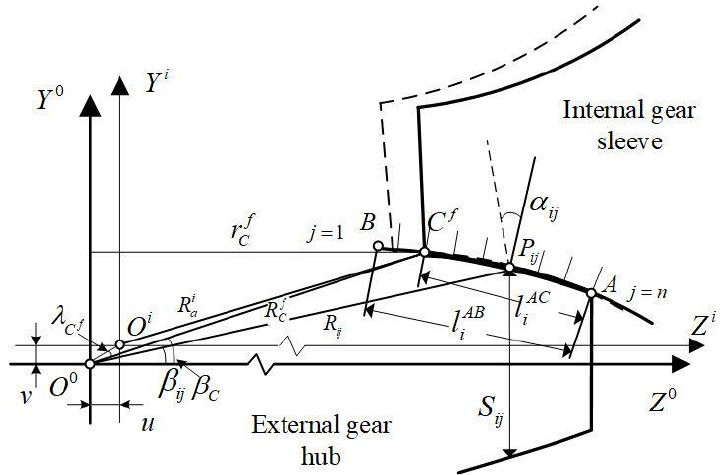
Figure 3. The meshing model of equal division for involute teeth with parallel misalignment. When the axis of the internal gear sleeve and external gear hub is offset, AB